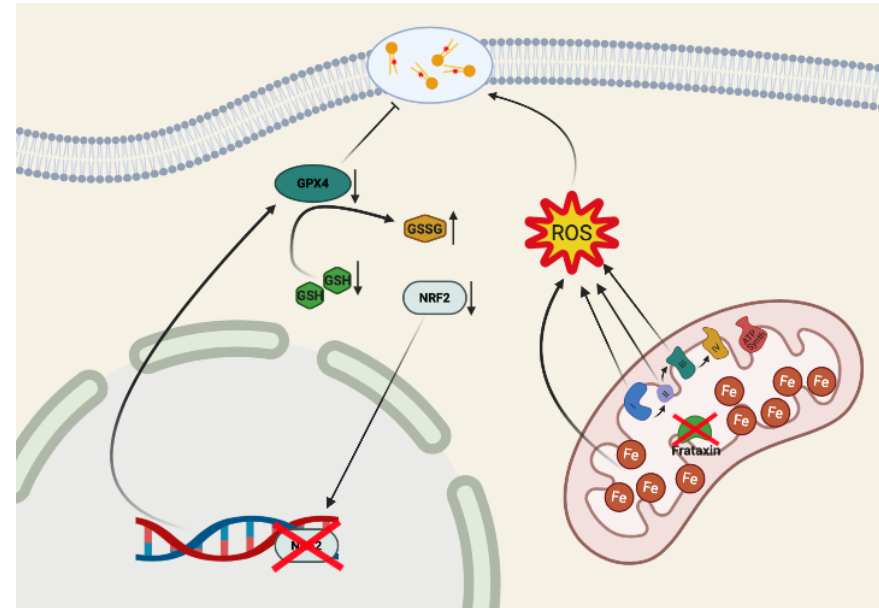
Figure 2. Ferroptosis hallmarks in Friedreich’s Ataxia (FA). In FA, the decrease of frataxin expression determines iron accumulation in the mitochondria and impairments in the Fe–S cluster (ISC) biogenesis, leading to a dysfunctional respiratory chain. The Fenton’s reaction-induced increase of ROS determines the lipid peroxidation of membrane polyunsaturated fatty acids (PUFAs). In FA, the cellular antioxidant defense is faulty, and NF-E2 p45-related factor 2 (NRF2) expression and activity are reduced, leading to a decrease of glutathione (GSH) and GPX4, potentially lowering the threshold needed for ferroptosis induction.